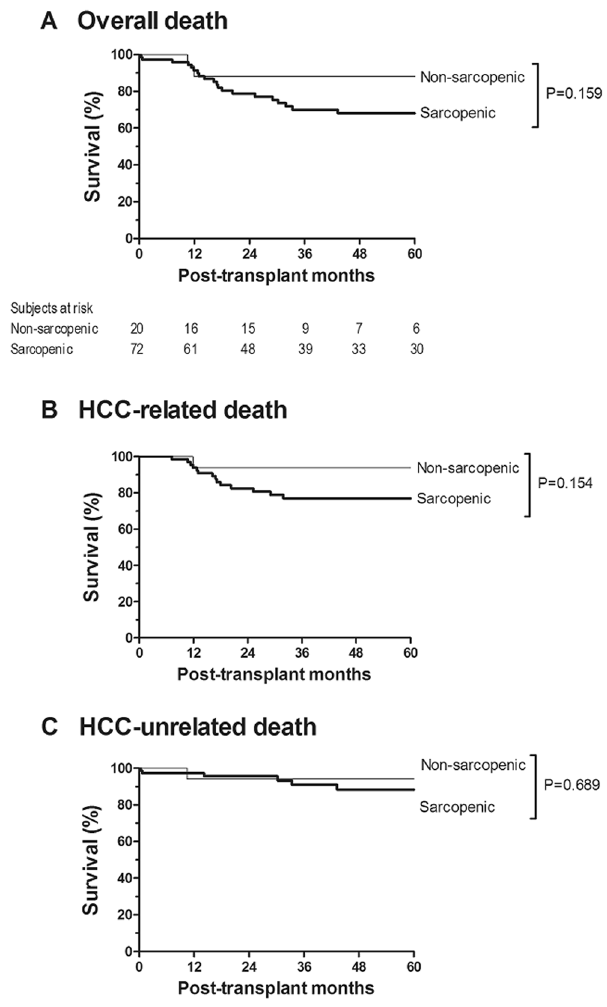
Figure 5. Survival probability according to the presence of sarcopenia. ( A ) Overall death, ( B ) HCC-related death, and ( C ) HCC-unrelated